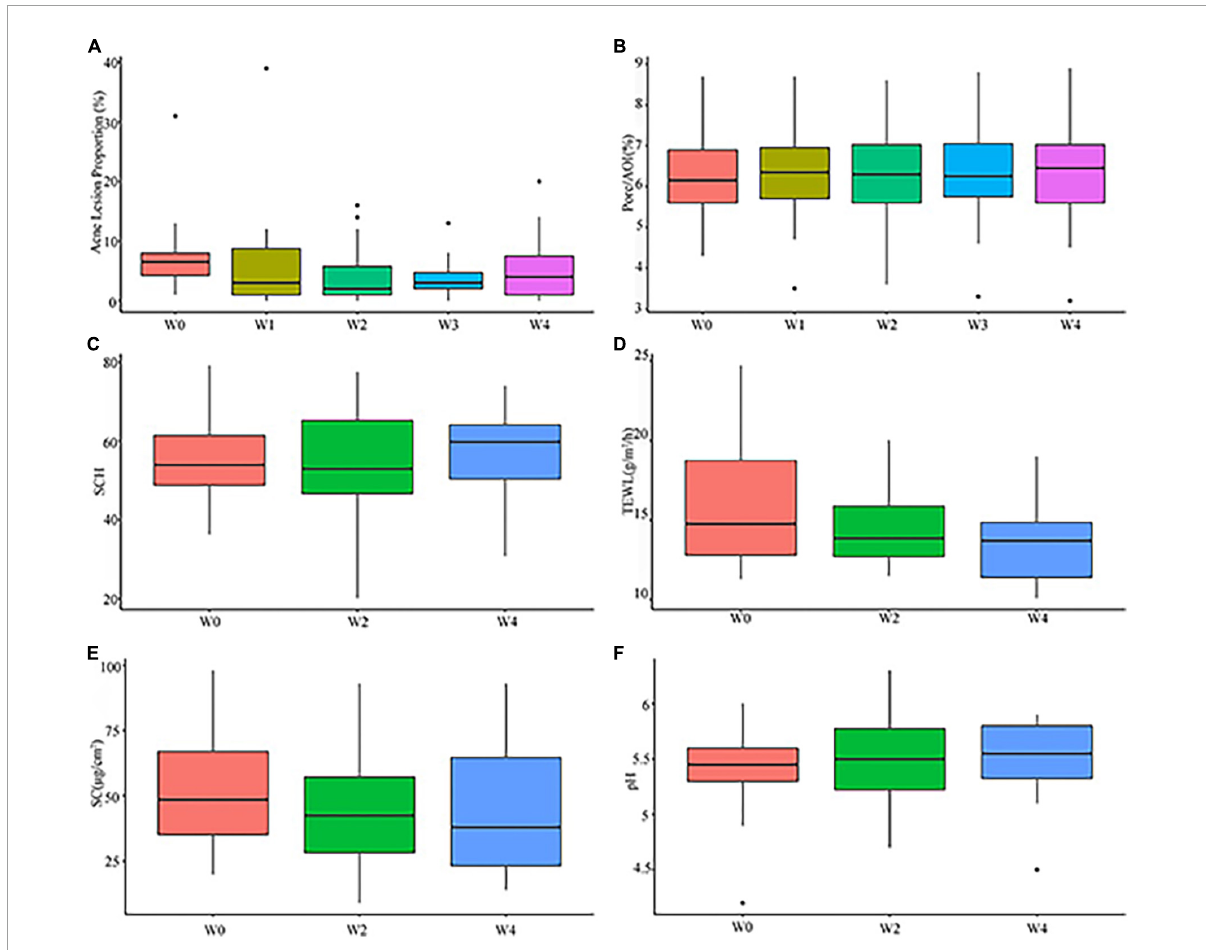
FIGURE3 Clinical assessment of subjects at Weeks 0 (W0),1 (W1), 2 (W2), 3 (W3), and 4 (W4): (A) proportions of acne lesion; (B) pore/AOI; (C) stratum corneum hydration (SCH); (D) transepidermal water loss (TEWL); (E) sebum contents (SC); (F)